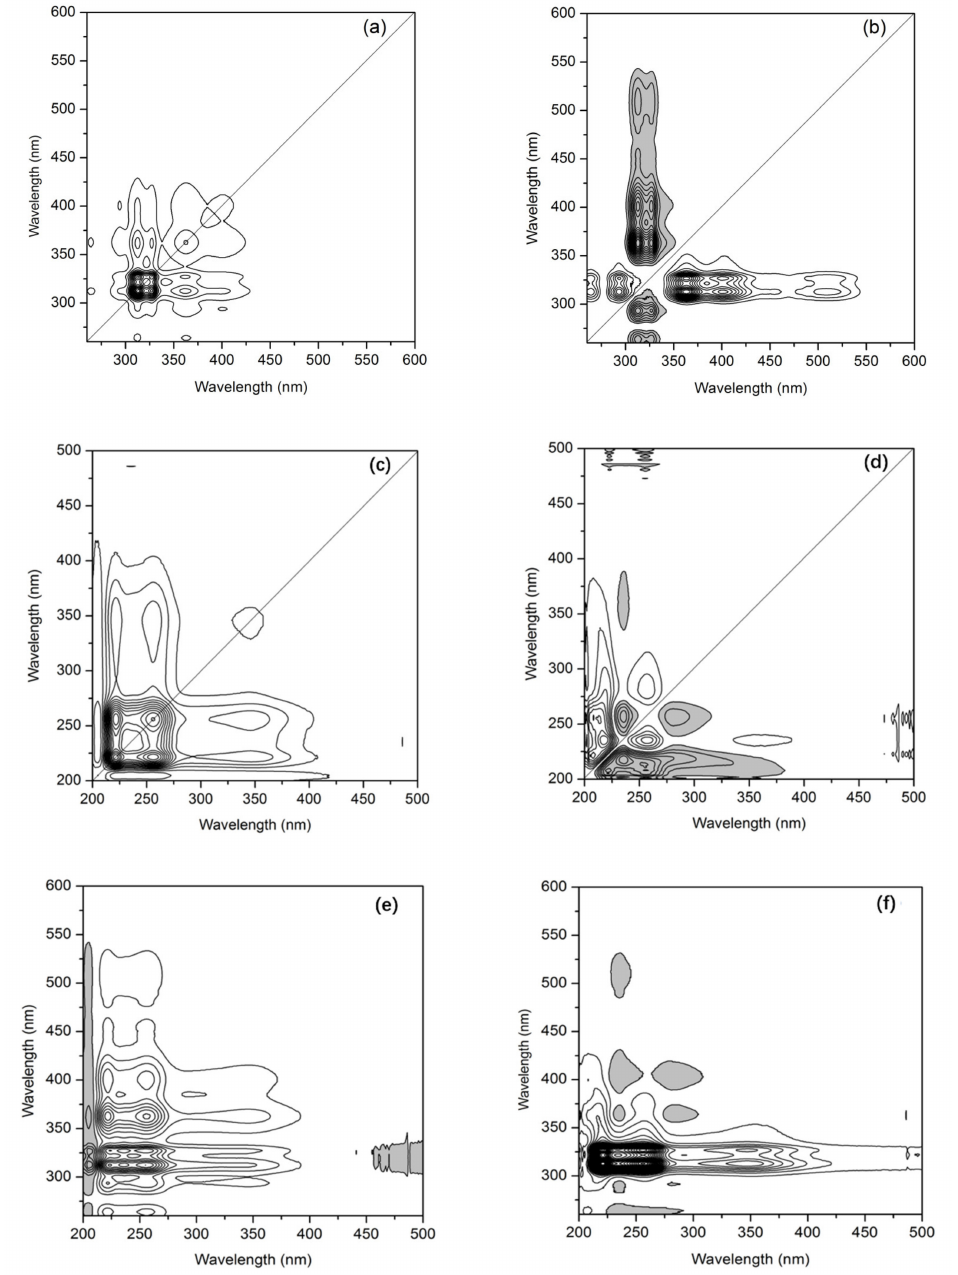
Figure 5. Two-dimensional- (2D)-correlation spectroscopy results of PTW: ( a ) synchronous fluorescence map, ( b ) asynchronous fluorescence map, ( c ) synchronous UV-visible map, ( d ) asynchronous UV-visible map, ( e ) synchronous fluorescence / UV-visible two-dimensional correlation map, ( f ) asynchronous fluorescence / UV-visible two-dimensional correlation map. The solid and the gray represent the positive and negative signs,